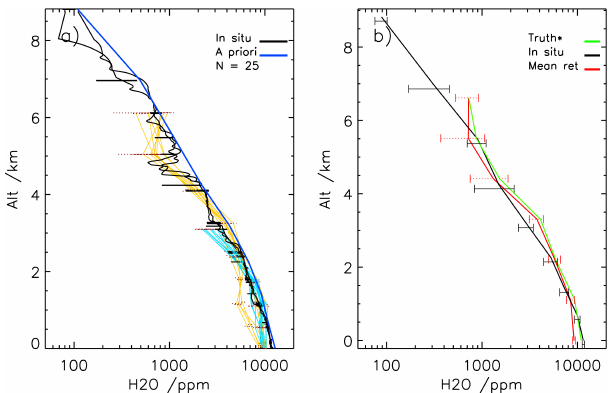
Figure 5. Retrievals and comparison to in situ data for (a) water vapour retrieval concentration profiles for flight B725 colour coded for flight altitude (light blue corresponds to 3km, orange to 6.1km). Retrieval uncertainty is shown as the dotted red bars for each pro- file. In situ dropsonde (black) and a priori profiles (blue) are also shown. (b) Weighted-mean profiles from flight B725 for retrieved (red), in situ measured (black), and in situ average convolved with ARIES averaging kernels (green). The standard deviation on the mean-retrieved profiles and the corresponding in situ 1 σ are shown as correspondingly coloured bars at each vertical